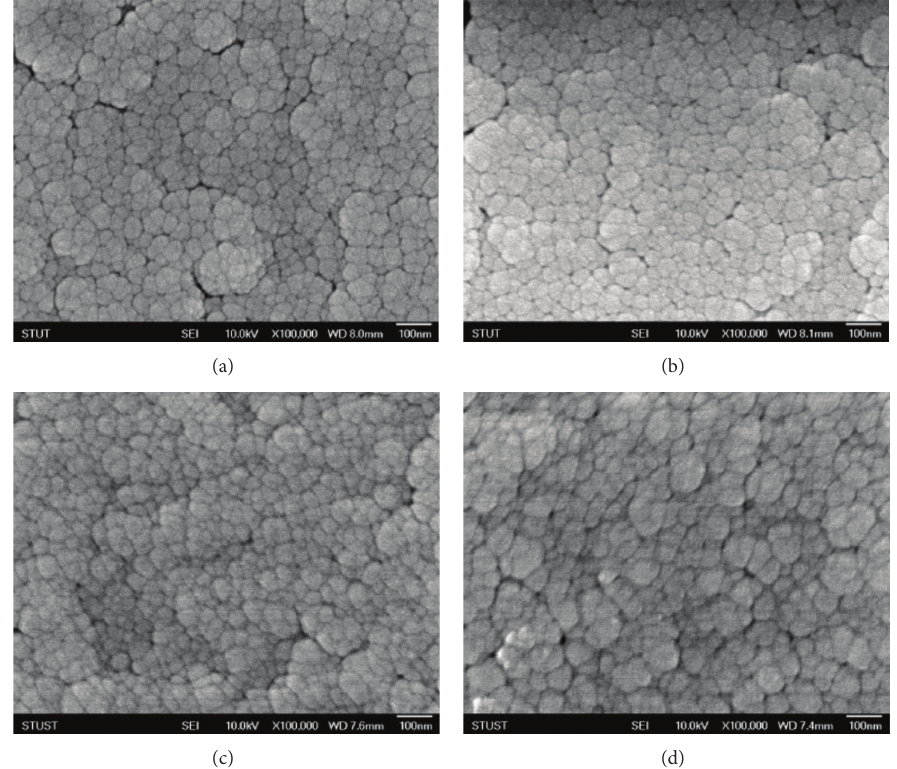
Figure 2: Surface morphologies of the CBTi144 films with (a) no annealing, (b) 450 ∘ C RTA, (c) 500 ∘ C RTA, and (d) 550 ∘ C RTA.